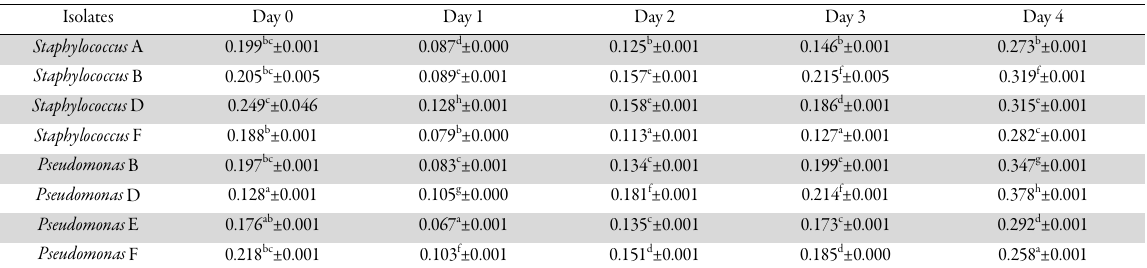
Table 4. Growth rate of Staphylococcus and Pseudomonas spp. after